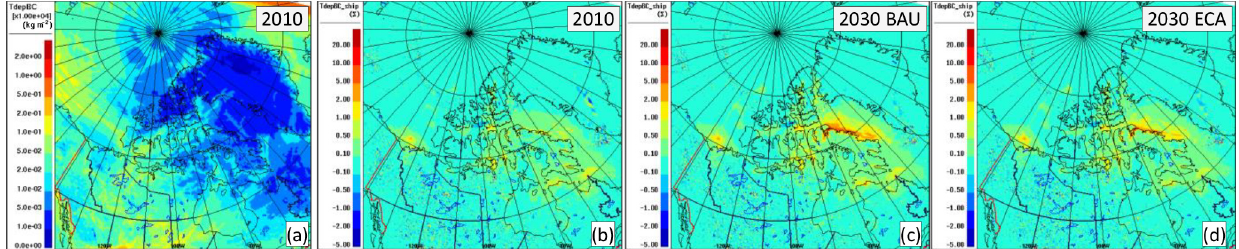
Figure 19. Modelled total BC deposition flux (scaled up by 10 4 , in kgm − 2 ) accumulated over the 2010 July–August–September period (a) , and relative contributions from Canadian Arctic shipping emissions: (b) 2010 base year, (c) 2030 BAU, and (d) 2030 ECA.